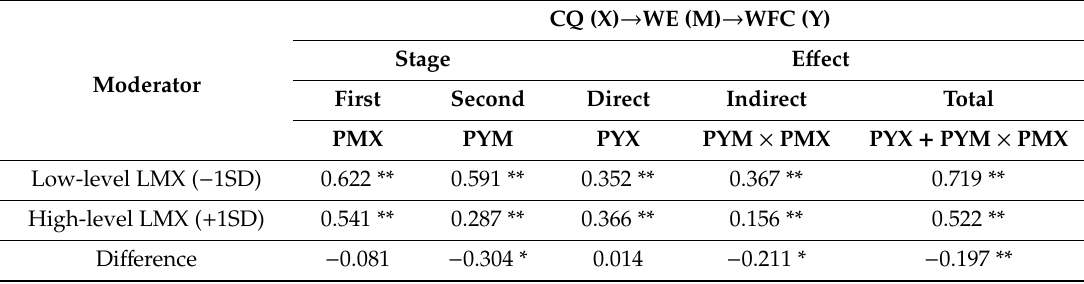
Table 4. Results of the moderated path